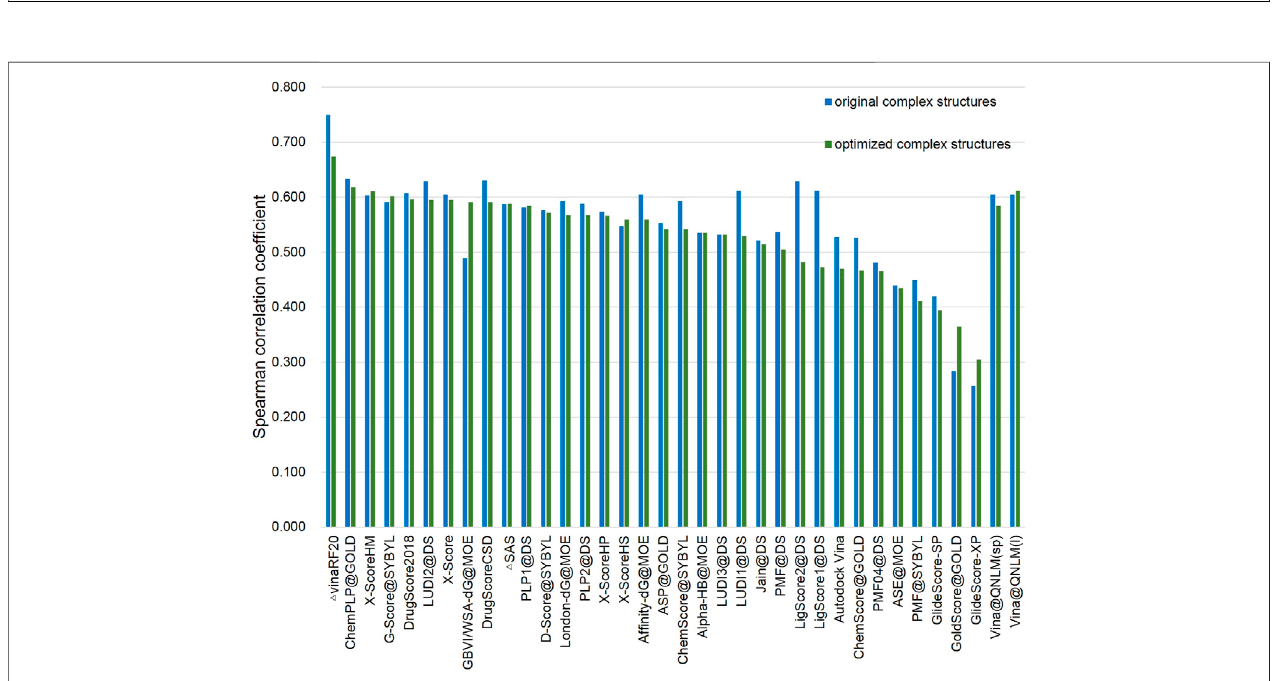
FIGURE8| ScoringpoweroforiginalcomplexstructuresandoptimizedcomplexstructuresandSpearman ’ scorrelationcoef fi cientsofVina@QNLMinsingle-point (sp) and local (l) modes (blue and green bars), compared to the methods evaluated in CASF-2016 and recalculated.